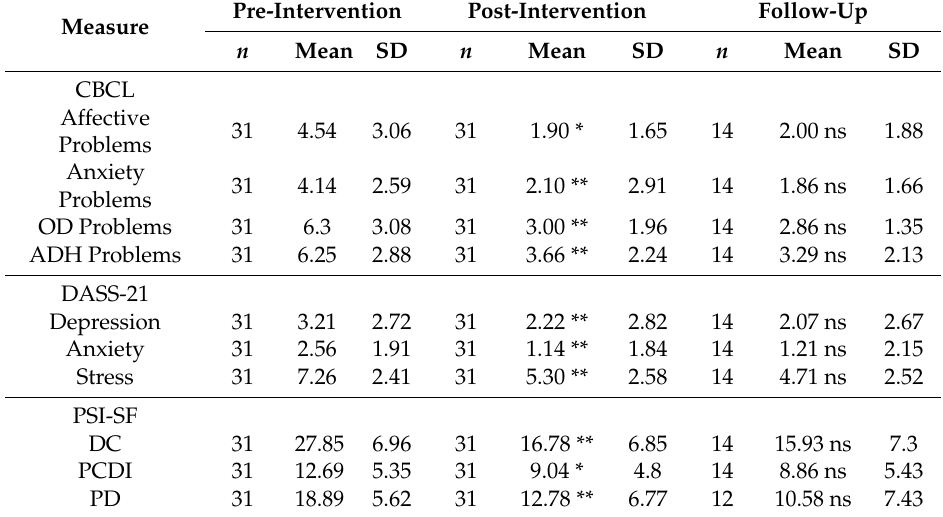
Table 2. Change in the Child Behaviour Checklist (CBCL) 1 1 Short Form (PSI-SF) scores from pre- to post-treatment and